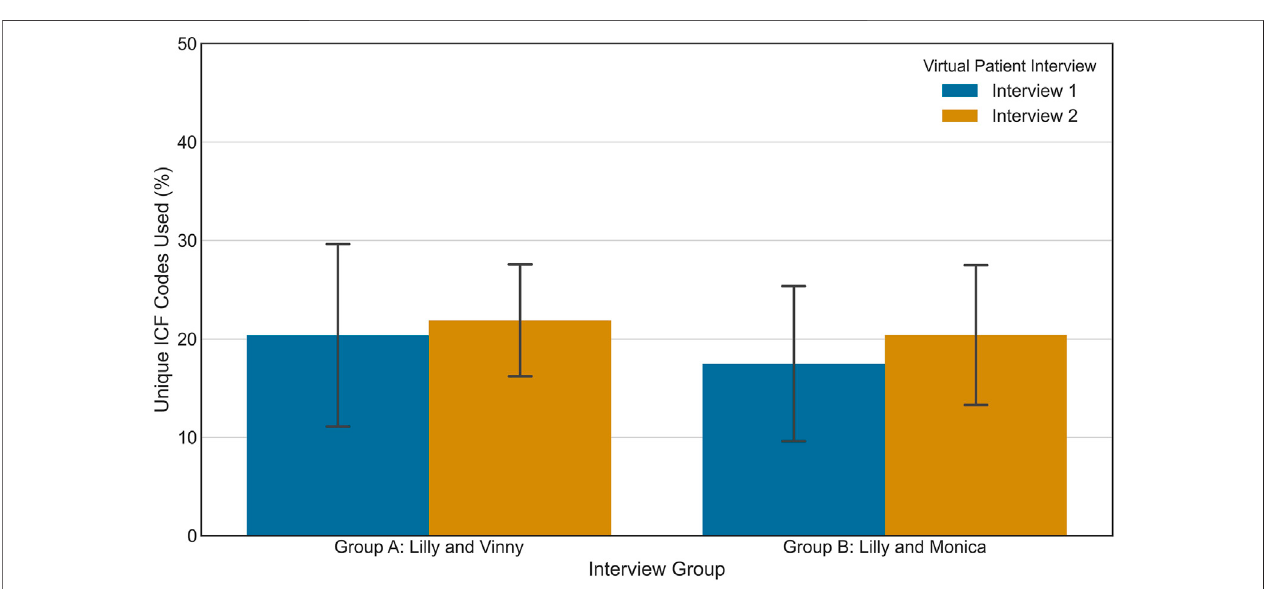
Frontiers in Virtual Reality |